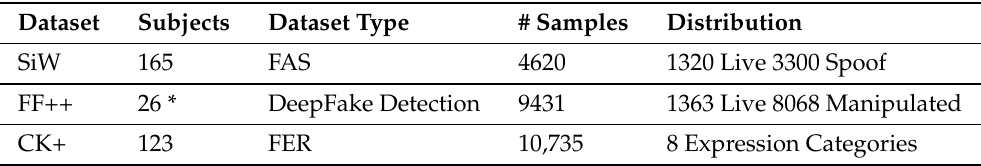
Table 1. Dataset descriptions: * Recorded actors only. YouTube video count not